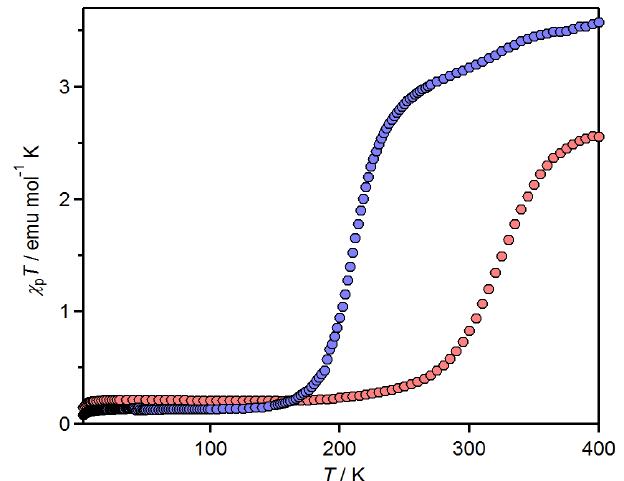
Figure 3. Temperature dependence of χ (NCS) ] (red) [53]. Adapted by permission of The Royal Society of [Fe(tdap) 2 2